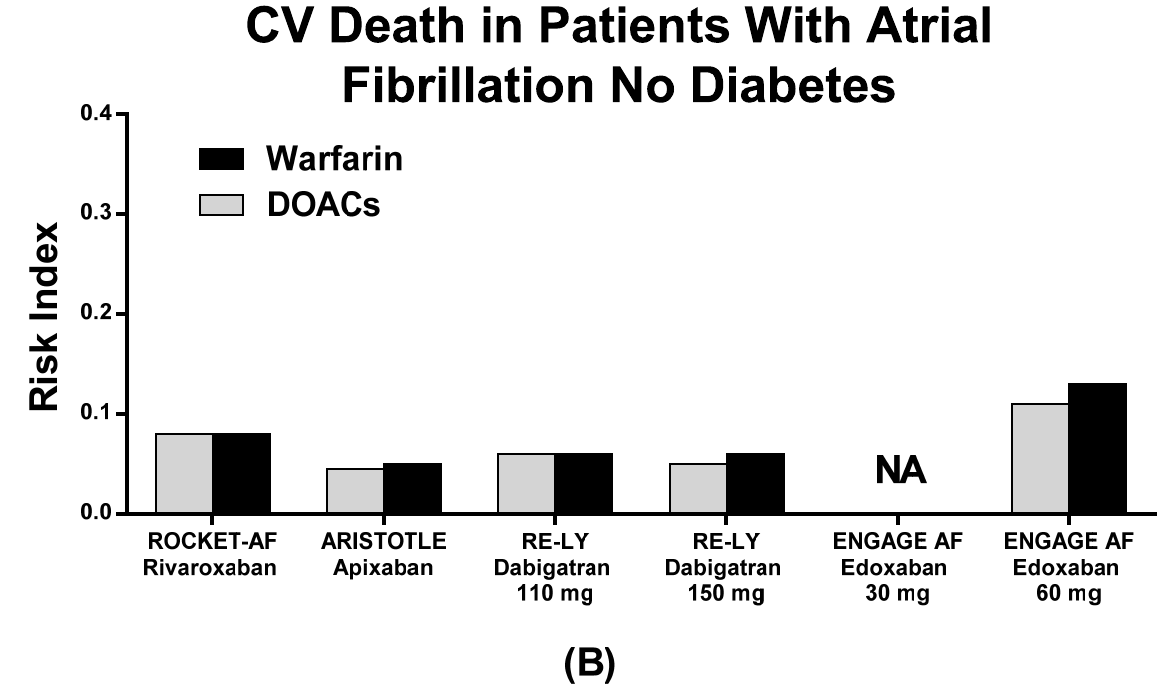
Figure 3. Risk index of CV Death in patients with ( A ) and without ( B ) diabetes in the pivotal trials.